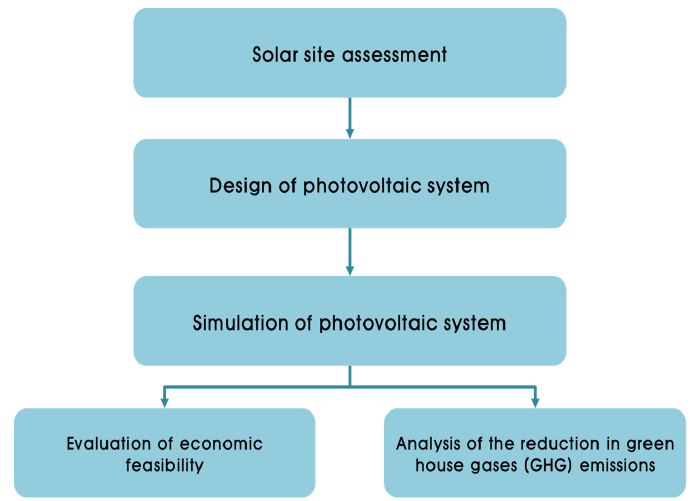
Figure 2. Overall procedure to assess the potential of a 1 ‐ MW floating photovoltaic system in the study site. study